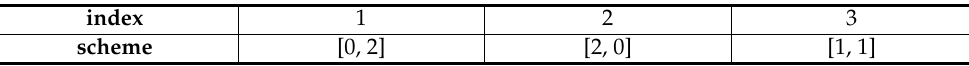
Table 1. Jamming power allocation schemes.